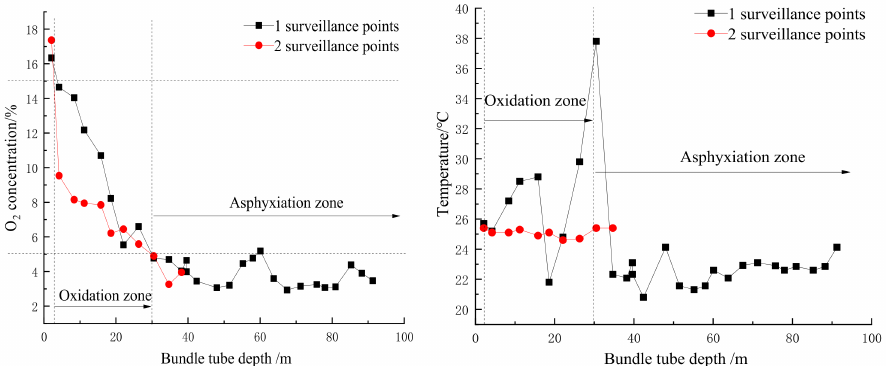
Figure 8. The influence of the bundle tube depth on the O 2 concentration and temperature in the surveillance